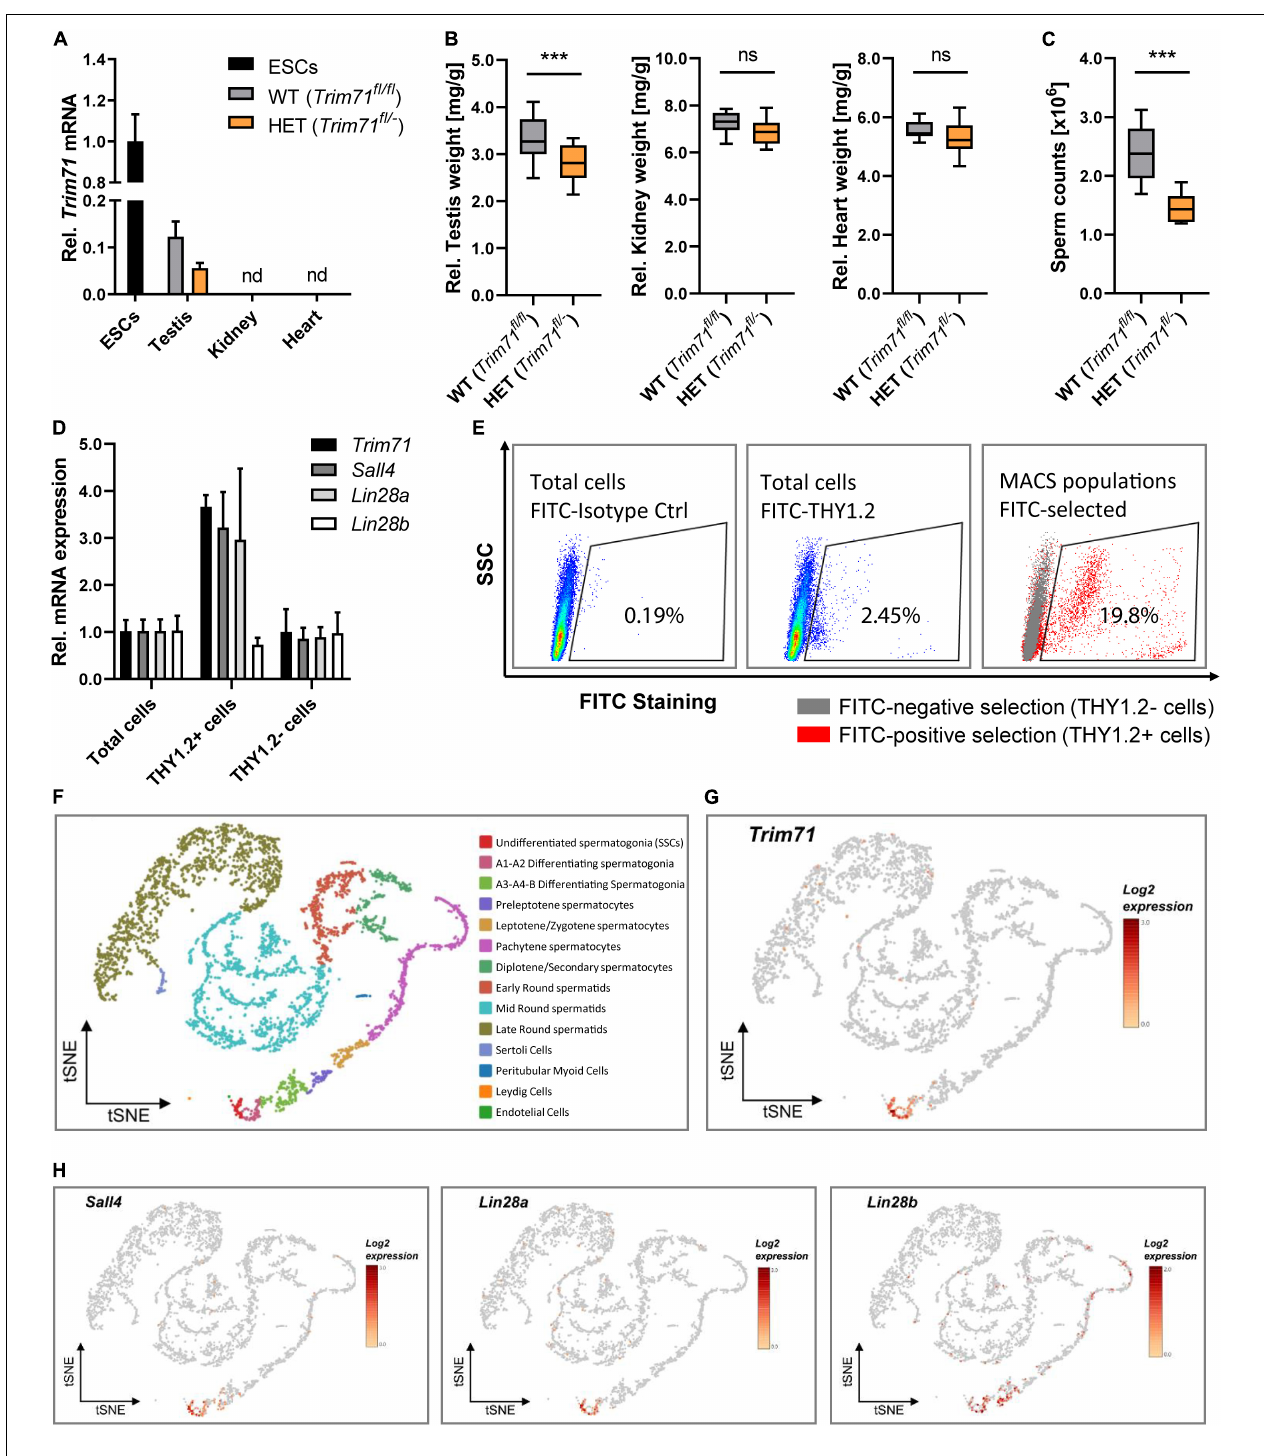
FIGURE 1 | Trim71 is expressed in spermatogonial stem cells (SSCs) of adult fertile mice. (A) qRT-PCR of Trim71 relative to Hprt housekeeping gene in testis, kidney and heart of wild type (WT, Trim71 fl / fl ) and Trim71 heterozygous (HET, Trim71 fl / − ) adult male mice (10–14 weeks old), normalized to Trim71 relative levels in wild type murine ESCs (nd, not detected). Error bars represent SD ( n = 3). (B) Organ weight [mg] relative to total body weight [g] of testis, kidney and heart of wild type (WT, Trim71 fl / fl ) and Trim71 heterozygous (HET, Trim71 fl / − ) male adult mice (10–14 weeks old). Graphs represent Tukey plots ( n = 14–16). *** P -value < 0.005, ns, non-significant (unpaired Student’s t -test). (C) Epididymal sperm counts in wild type (WT, Trim71 fl / fl ) and Trim71 heterozygous (HET, Trim71 fl / − ) male adult mice (10–14 weeks old). *** P -value < 0.005 (unpaired Student’s t -test). (D) qRT-PCR of Trim71 , the SSC markers Sall4 and Lin28a, and the differentiating spermatogonia marker Lin28b , relative to Hprt housekeeping gene in testes cell suspension before (total cells) and after THY1.2 MACS (THY1.2+/ − cells). Error bars represent